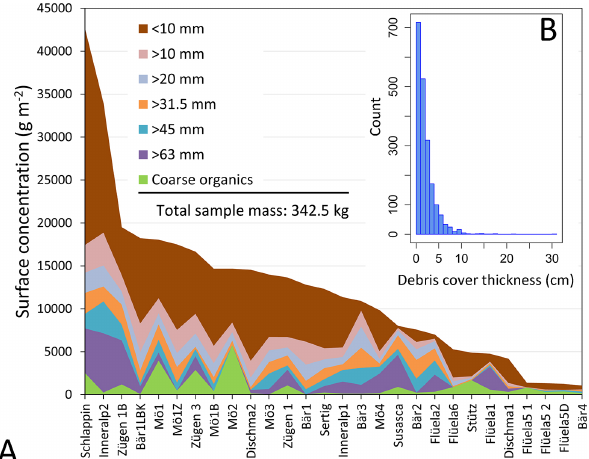
Fig. 3. Characteristics of debris cover on the surface of n = 28 wet snow-avalanche deposits. (A) Grain-size characteristics and surface concentration of debris cover from n = 28 snow-avalanche cones. Most organic content is contained in the size fraction <2mm. (B) Histogram of debris-cover thickness measured blindfolded and randomly on all avalanche surfaces ( n = 2800 point measurements).